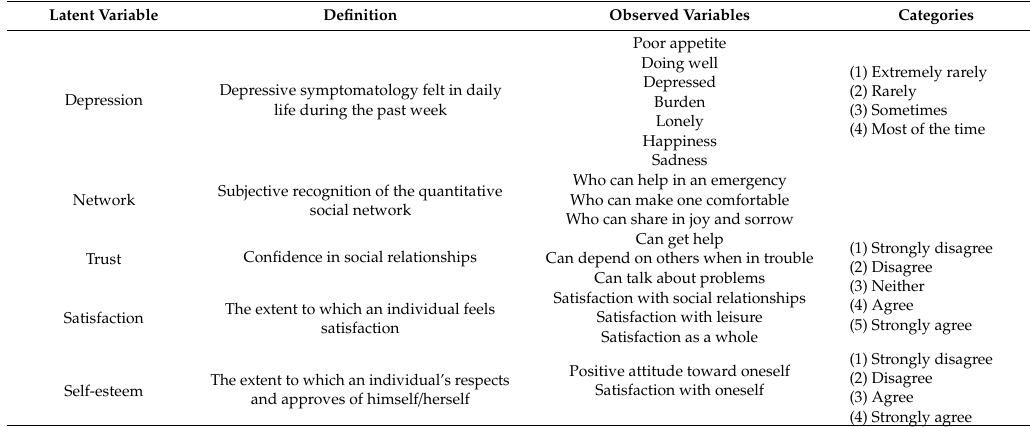
Table 1. Measurements of the variables in this